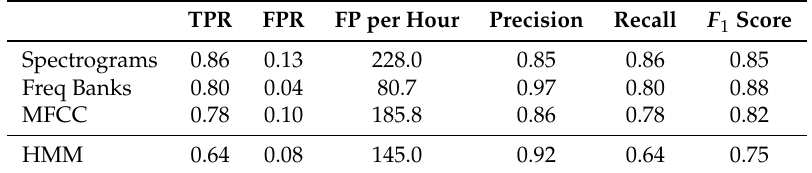
Table 2. Detection metrics for three different pre-processing techniques used before training a convolutional neural network: standard spectrograms, mel-scale frequency banks, and mel-frequency cepstrum coefficients. Also included for comparison is the same metrics for the HMM. The accuracies were based on the detectors’ ability to discern between background noise and gunshots up to 800 m away. TPR FPR FP per Hour Precision Recall F 1 Score Spectrograms